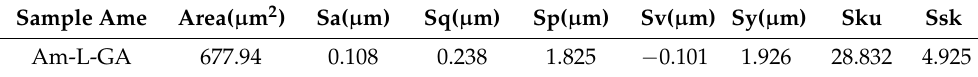
Table 1. Roughness parameters.